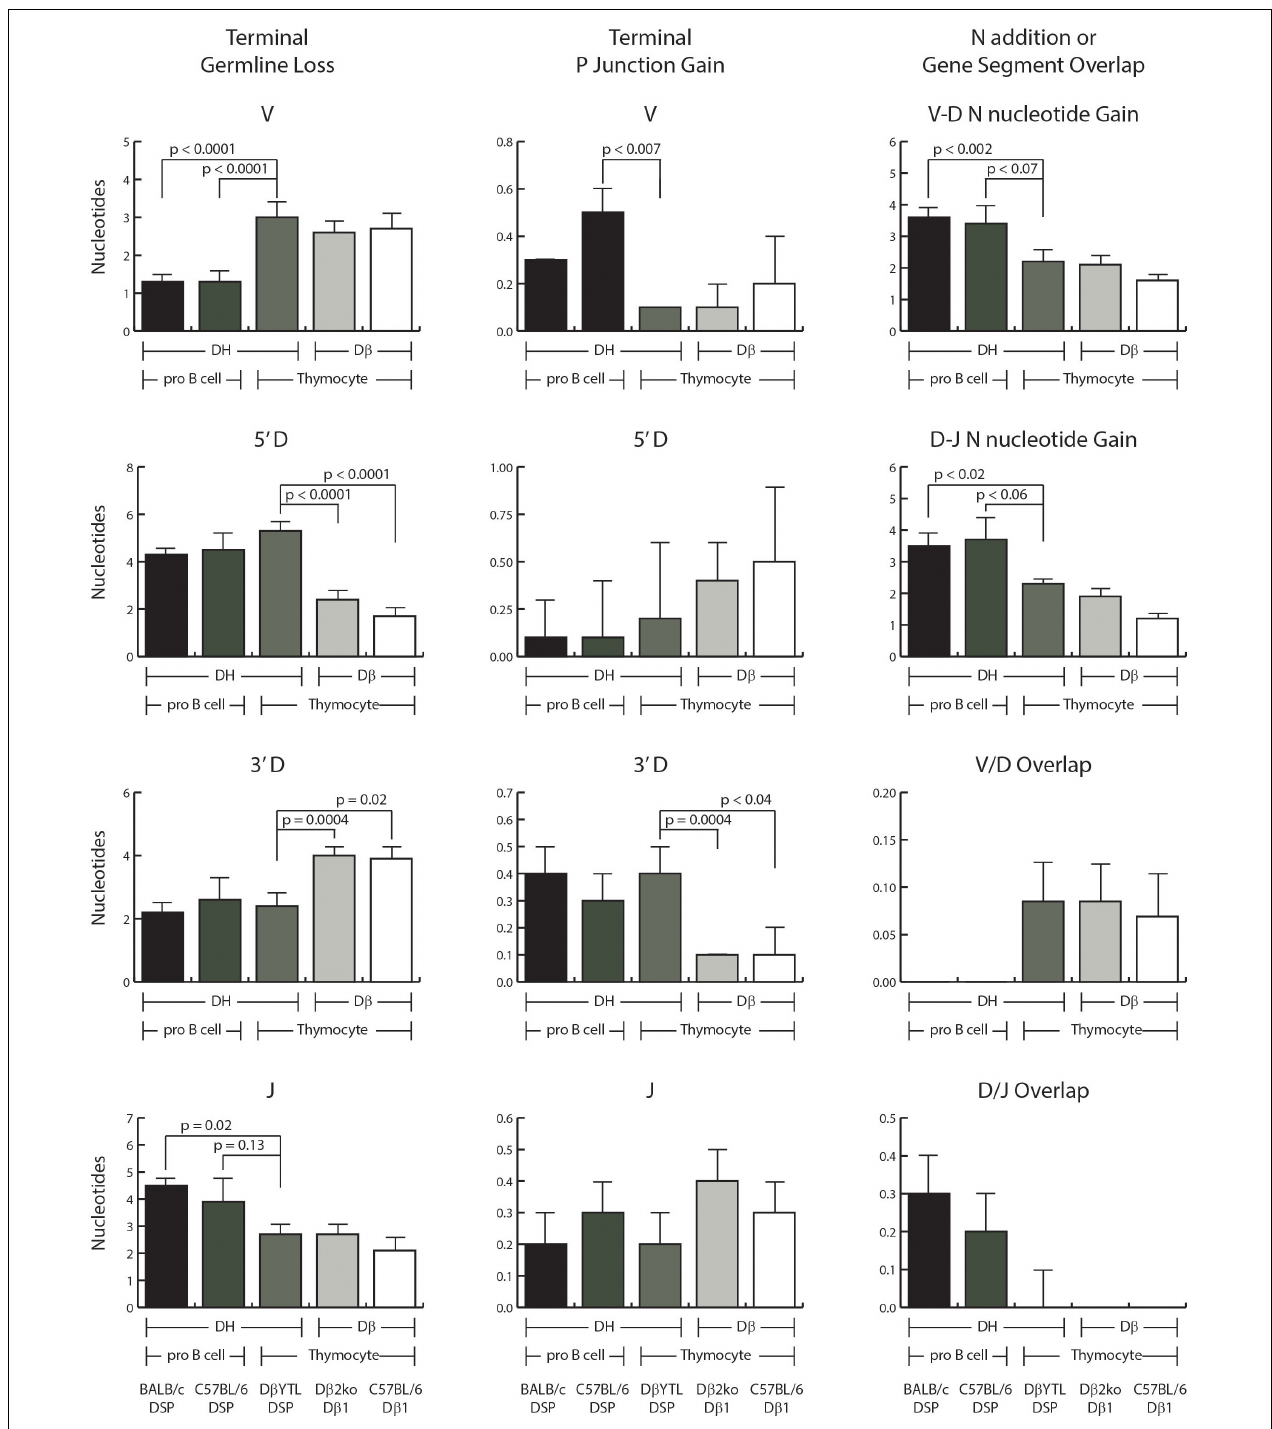
FIGURE 2 | Comparisons of VDJ processing in the pre-selected repertoire. Shown in the left column is the average loss of terminal nucleotides in the V, D, and J gene segments. Shown in the middle column is the average amount of P junction addition. Shown in the right column is: row 1 and 2, the average amount of N nucleotide addition between V and D and between D and J, respectively; row 3 and 4, the extent of V/D and D/J overlap in sequence among sequences lacking N addition. In each case, the data are ordered, from left to right: wild type BALB/c DSP containing sequences, wild type C57BL/6 DSP containing sequences, D β YTL containing sequences, D β 1 containing sequences from the D β 2ko mice and from wild type C57BL/6 mice. From left to right, the first three columns represent D H sequences and columns four and five are D β sequences. From left to right, the first two columns of each graph represent data from Fraction B proB cells, followed by the three columns of each graph representing data from DN2 cells from thymocytes. Error bars display the standard error of the mean. Statistical analysis was performed only for D β YTL in comparison with the four controls, and comparisons lacking a “ p ” value all have p > 0.05.